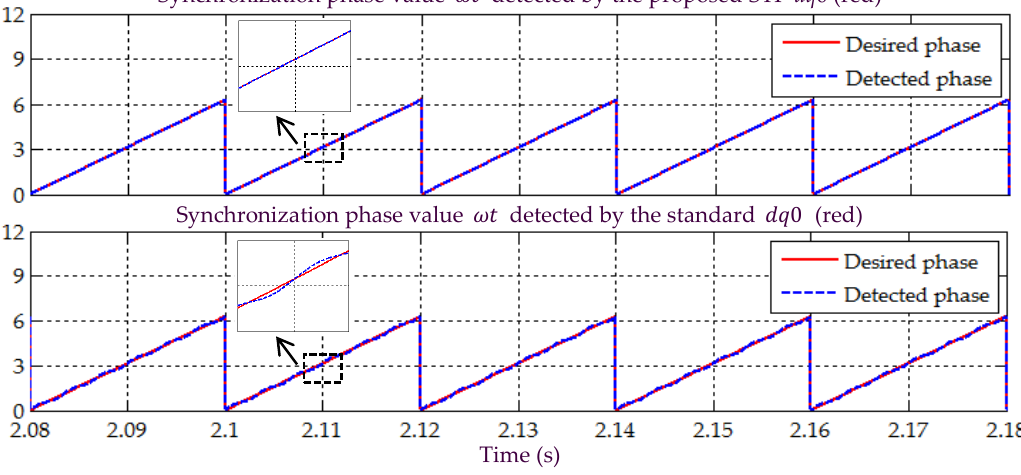
Figure 10. Simulation result showing the detected synchronization reference phase value ω t under Scenario